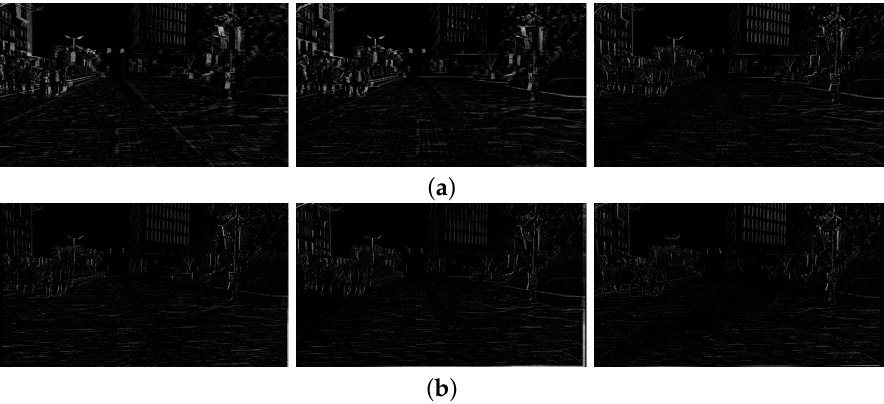
Figure 15. Experimental results of the video stabilization method: ( a ) differences of the original video (275th, 276th, and 277th frames), and ( b ) the stabilized video (275th, 276th, and 277th